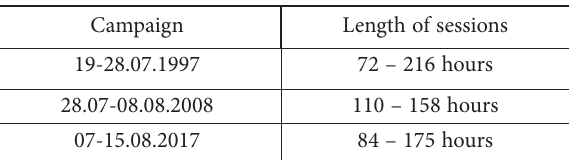
Table 2. The durations of Estonian I order geodetic network measurements Campaign Length of sessions